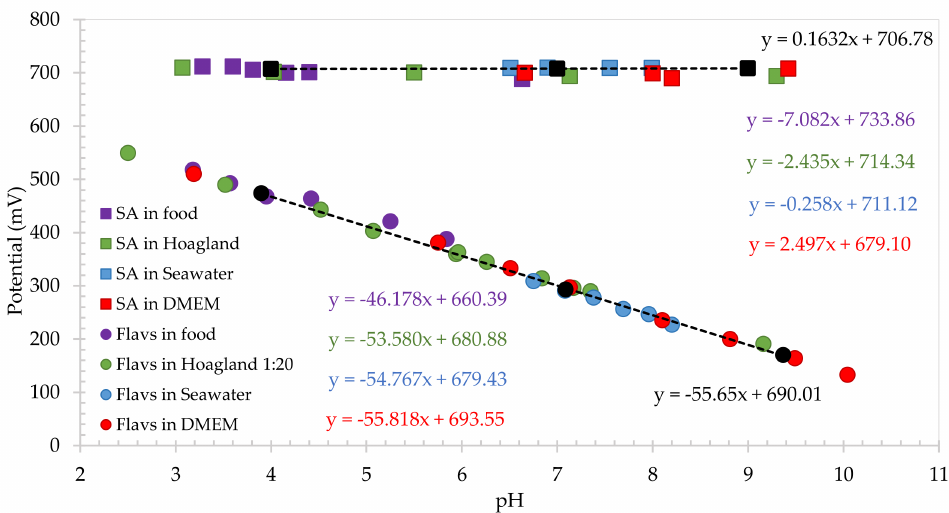
Figure 4. Calibration plot of salicylic acid-based pH insensitive (squares) and flavanone-based pH sensitive electrodes (circles) in different food medias, Hoagland diluted hydroponic solution, seawater/CO 2 system and DMEM solution.